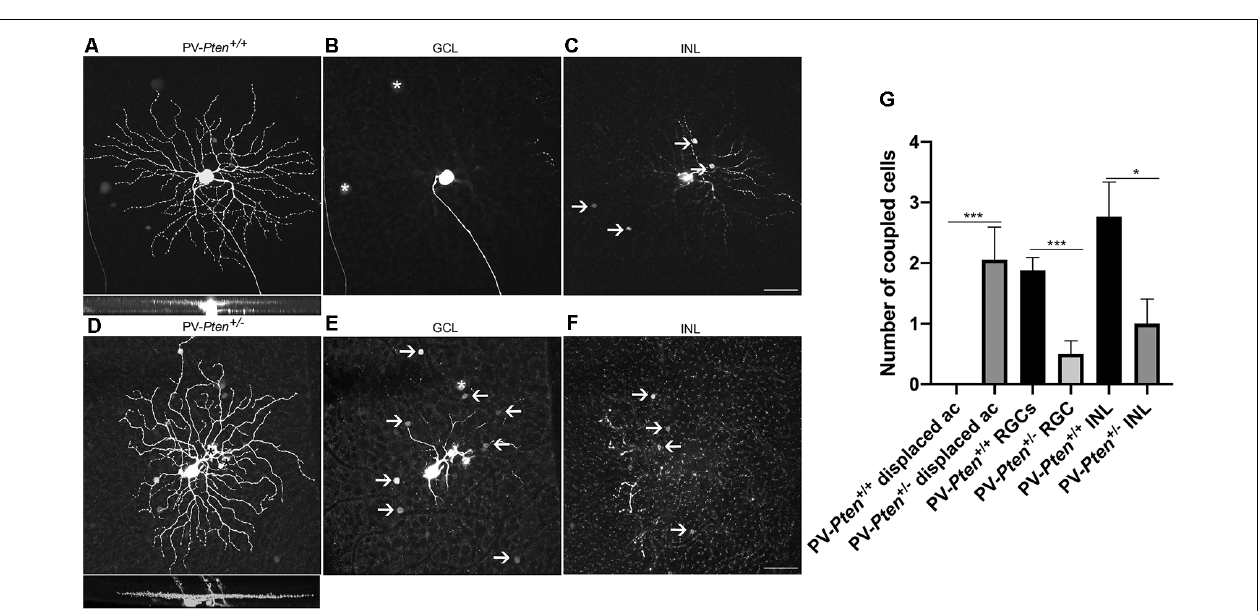
FIGURE 6 | Tracer coupling of ON α -RGCs in PV- Pten +/+ and PV- Pten + / − retinas. (A) Neurobiotin-filled ON α -RGC in PV- Pten +/+ retina and its stratification pattern. The ON α -RGC shows tracer-coupling to small cells in the GCL (arrows). (B) Neurobiotin-filled ON α -RGC in a PV- Pten + / − retina and its stratification pattern. The ON α -RGC shows no tracer-coupling. (C) Histogram indicating the mean ( ± SEM) number of cells coupled to ON α -RGCs ( n = 18 cells from PV- Pten +/+ mice, n = 9 cells from PV- Pten + / − mice, P < 0.005, Mann-Whitney test). z-step = 0.3 µ m. 40–60 optical sections were compressed for viewing. Scale bar = 50 µ m. ** P < 0.005.